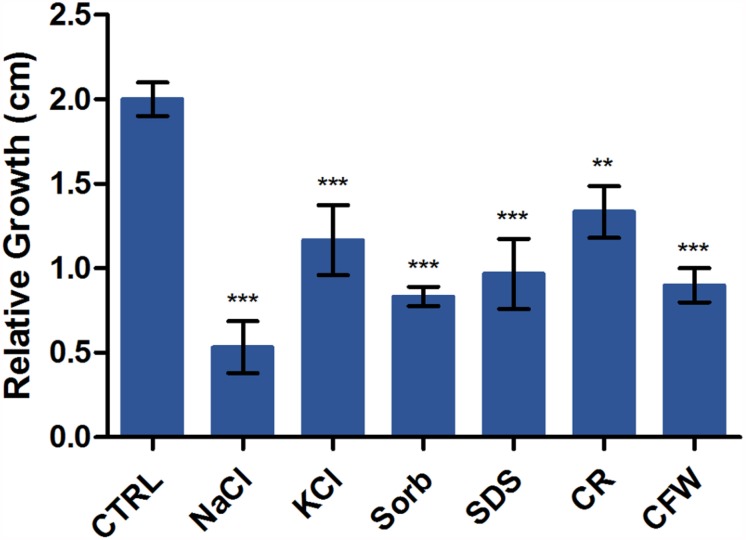
Susceptibility of T. rubrum to various stressors. Strains were inoculated on Sabouraud dextrose broth with or without the stressors NaCl, KCl, sorbitol (Sorb), SDS, Congo Red (CR), and Calcofluor White (CFW) at 28°C for 6 d. The graph represents the relative colony diameters (in centimeters) of each strain in the presence of the stressors relative to the control (CTRL), without the stressors. Data are means of three biological replicates. The error bar indicates the standard deviation (SD). Asterisks indicate statistical significance determined by ANOVA followed by Tukey’s ad hoc test (∗∗P < 0.01; ∗∗∗P < 0.001).